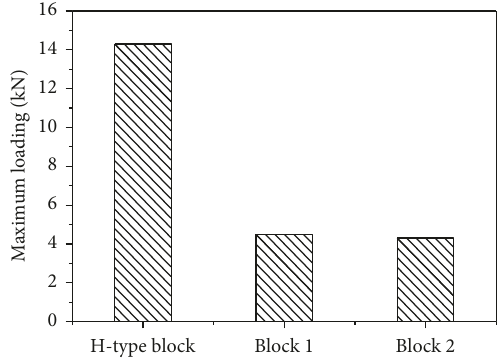
Figure 12: Maximum loading of three types of